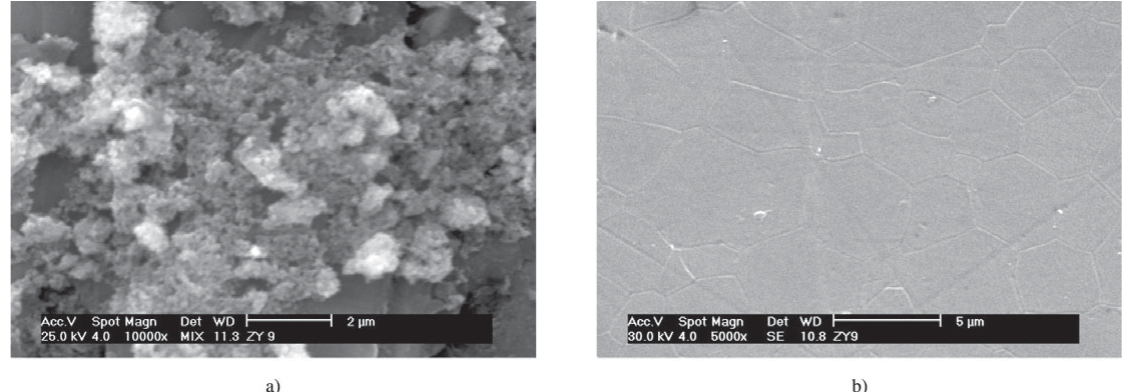
Figure 4. SEM micrograph of the powder (a); the thermally etched ZrO